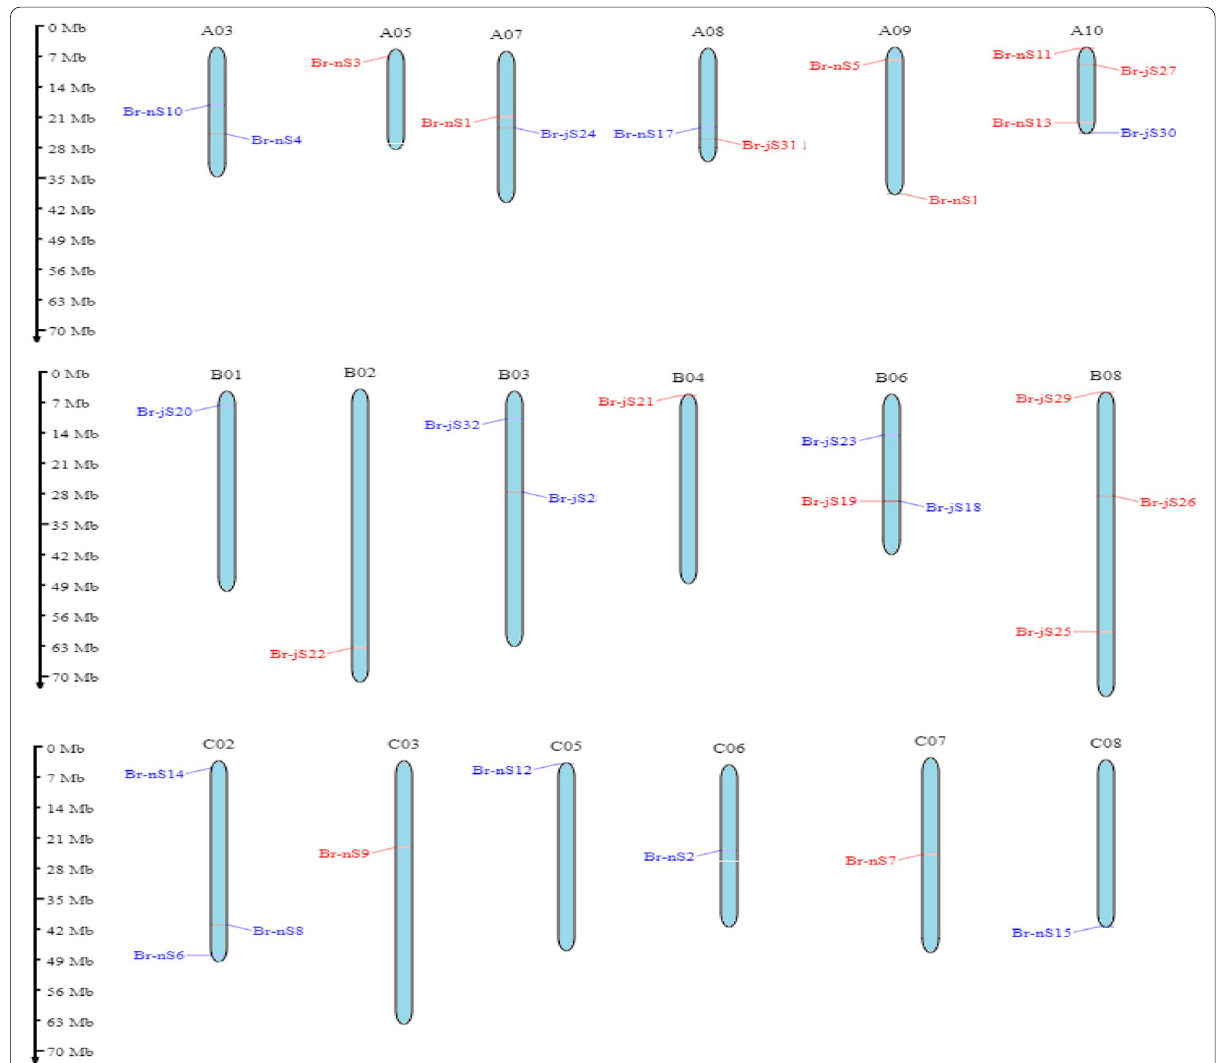
Fig. 4 Gene localization of shattering genes on B. napus and B. juncea